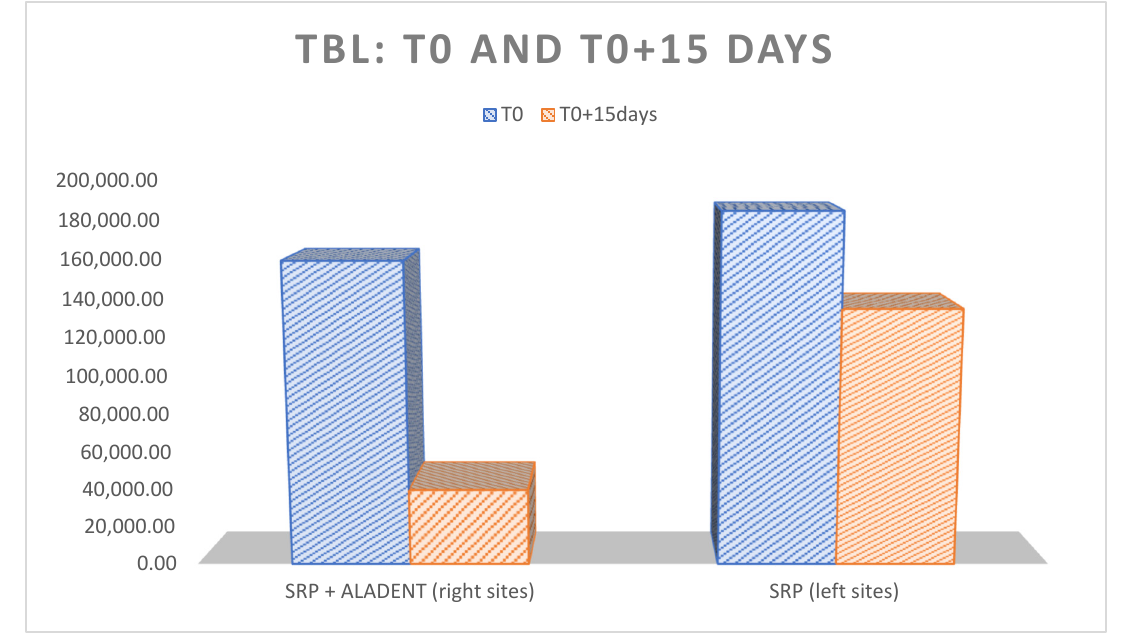
Figure 2. Total bacteria loading (TBL) before (time 0) and two weeks after treatment (time 0 + 15 days) in right ( R ) (SRP) and left ( L ) (SRP plus ALADENT) sites. Table 2. Total bacterial loading (TBL) reduction in the sites treated with SRP (left-L) compared to the site treated with SRP plus ALADENT (right-R).